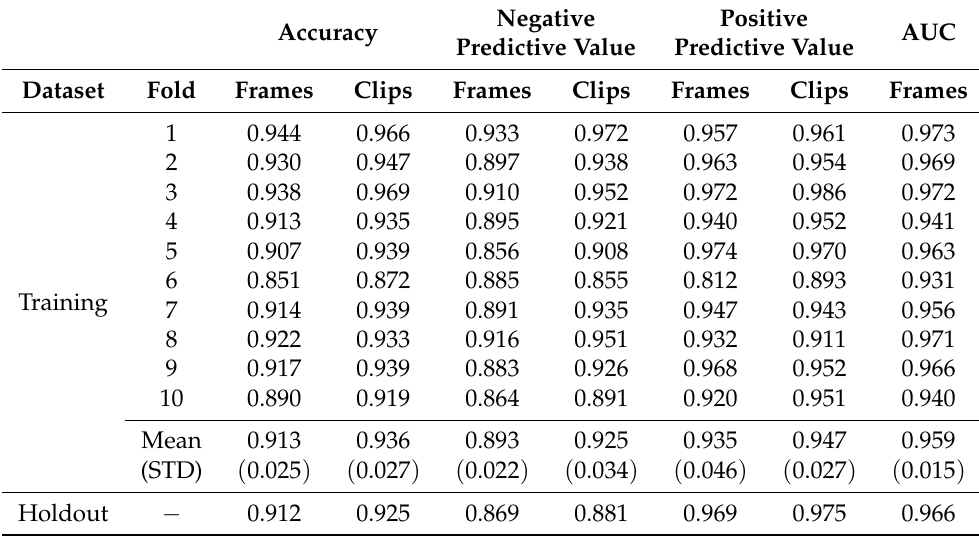
Table 3. Metrics for a 10-fold cross validation experiment and the holdout set